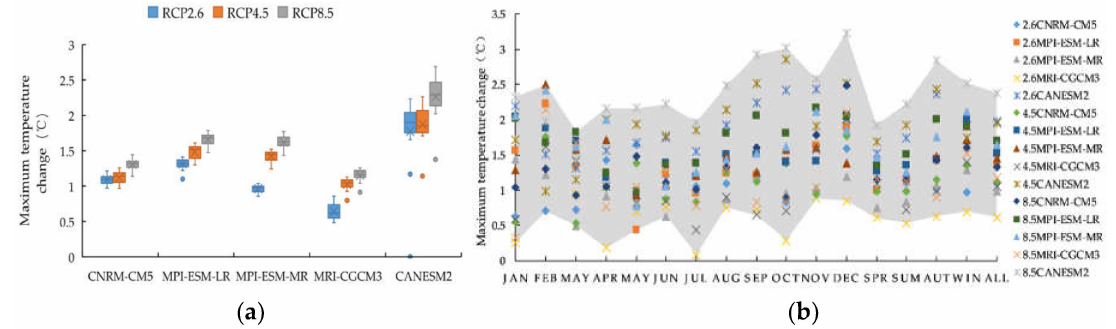
Figure 6. Multi-model projected change in mean maximum air temperature: ( a ) in different RCP scenarios; ( b ) at different time scales in the Heihe River